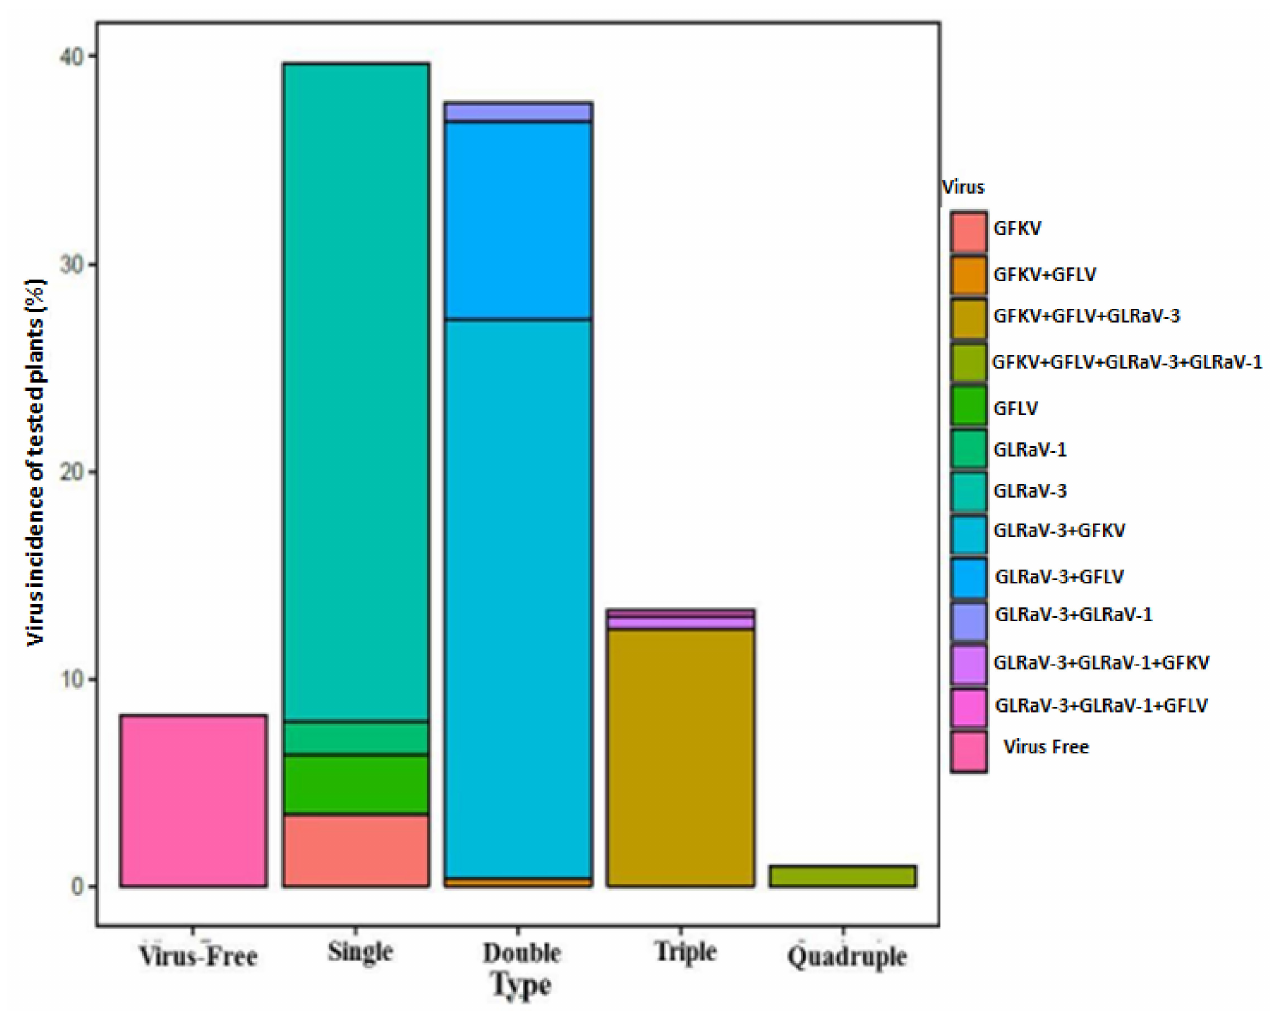
Figure 2. Simple and multiple virus incidences in the cultivars studied (in %). GLRaV-1: Grapevine leafroll-associated virus 1; GLRaV-3: Grapevine leafroll-associated virus 3; GFkV: Grapevine fleck virus; GFLV: Grapevine fanleaf